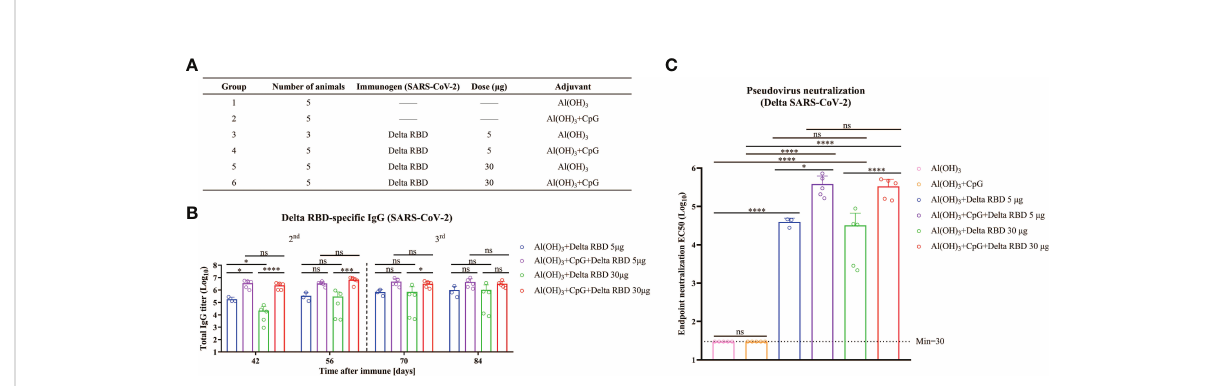
FIGURE 5 Humoral immune responses enhanced by formulating Delta RBD in conjunction with CpG+Alum adjuvant. (A) The treatment for different groups of mice. Mice were randomly grouped and intramuscularly injected according to immunization program 3. (B) Measurement of Delta RBD-speci fi c IgG titers in serum. (C) Quanti fi cation of the NAb titers against the Delta variant in the endpoint serum samples. Data are the mean ± SD. p -values were calculated using one-way ANOVA. * p < 0.05, *** p < 0.001, **** p < 0.0001; ns, not signi fi cant.